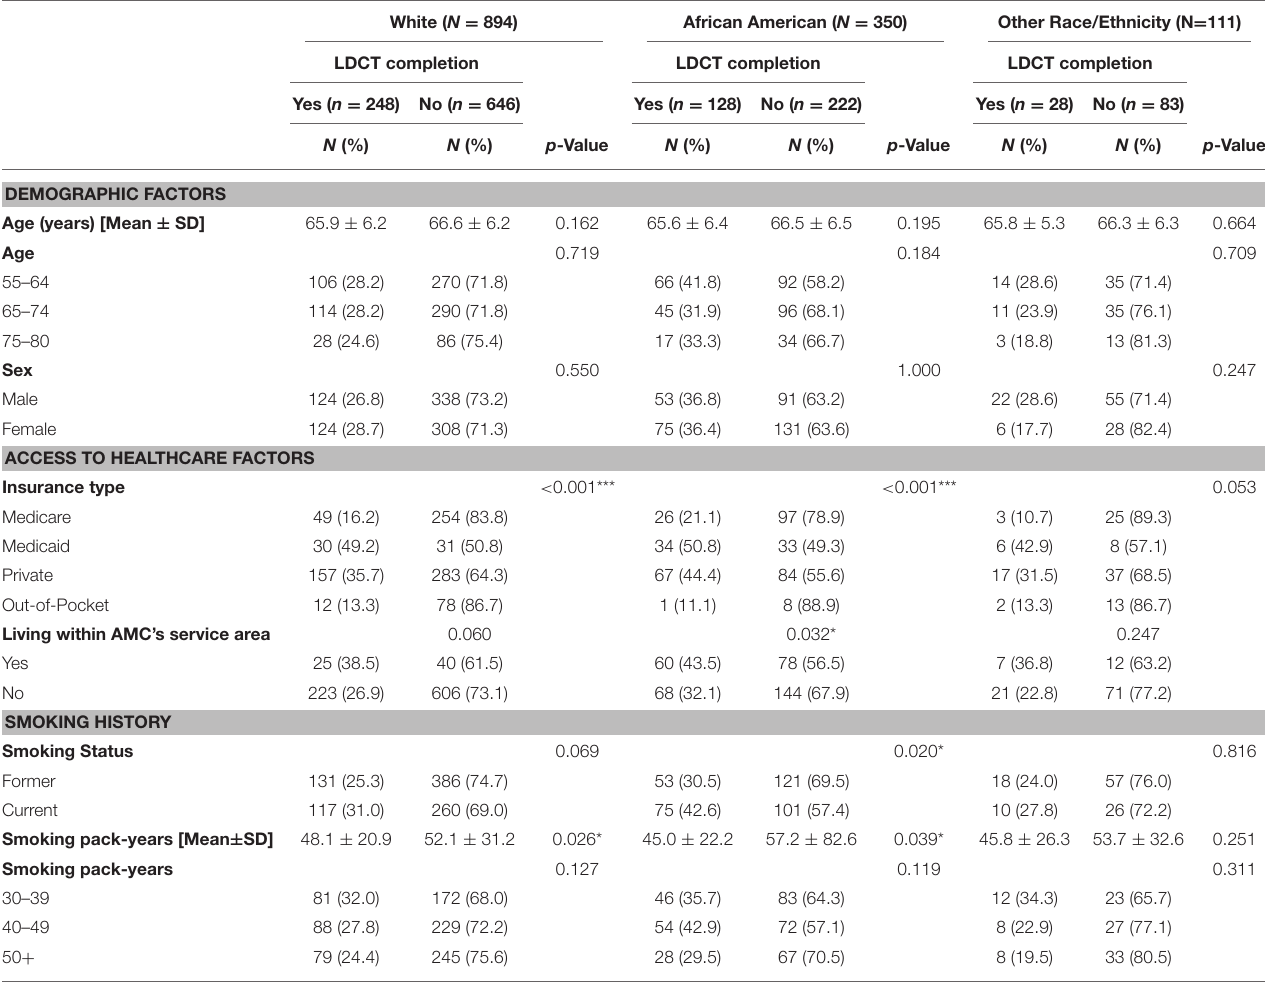
TABLE 2 | LDCT screening completion rates stratified by